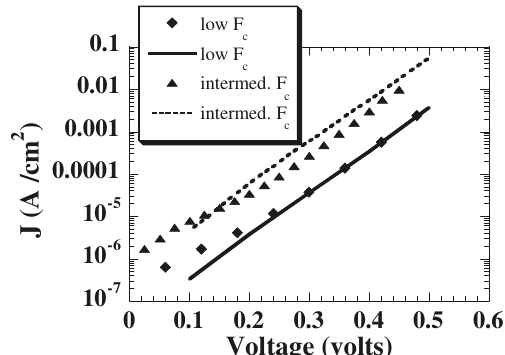
Fig. 3. Calculated dark J - V characteristics of the intermediate F F μ c-Si:H cells at 30 ◦ C, compared to experimen- c and low c tal results. The lines are our modeling results, while symbols represent experimental measurements.